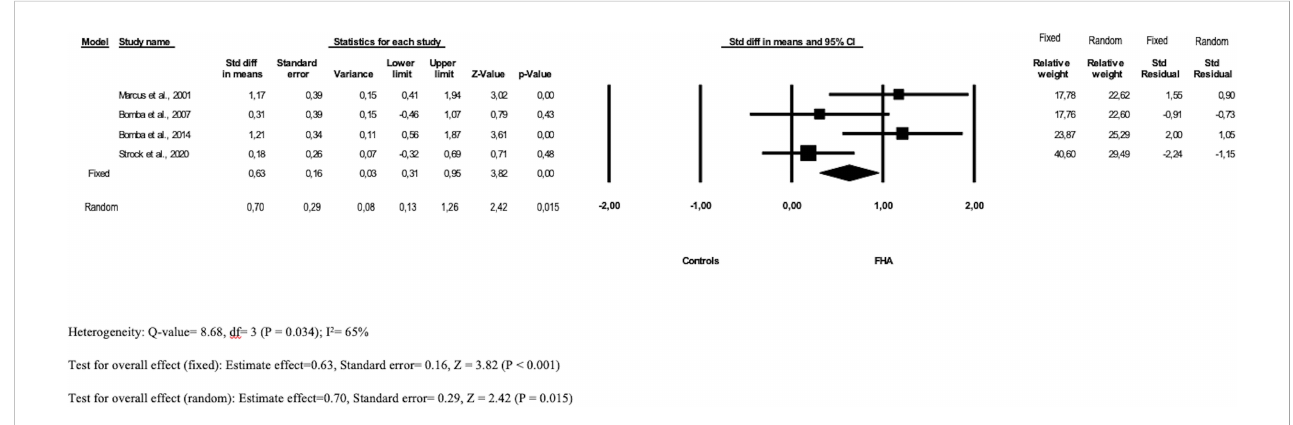
FIGURE 3 Forest plot of drive for thinness subscale prevalence in FHA patients and